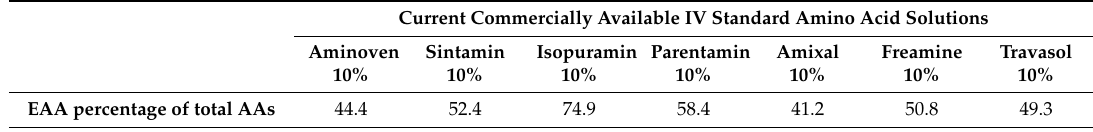
Table1. EAApercentageoftotalAAsinseveralcommerciallyavailableIVstandardaminoacidsolutions.